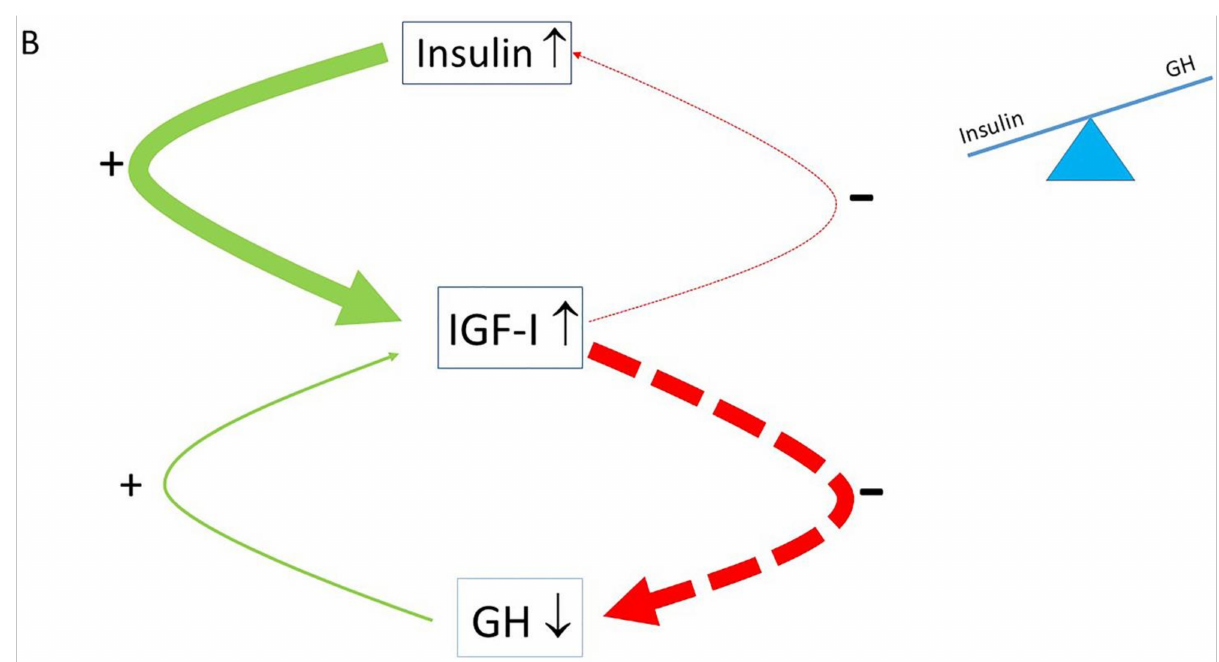
Figure 1. The insulin–growth hormone–IGF-I (insulin–GH–IGF-I) axis plays a central role in metabolism. ( A ) In healthy subjects, the insulin–GH–IGF-I axis is in balance: insulin and GH both stimulate IGF-I production in the liver, while after secretion IGF-I feeds back to suppress both insulin and GH. ( B ) The continuous food intake and energy surplus (Western diet) in modern societies has disturbed the normal balance of the insulin–GH–IGF-I axis. As a consequence, a shift of the insulin : GH ratio towards insulin (and IGF-I) and away from GH has occurred. The higher insulin : GH ratio lowers energy expenditure and induces fat accumulation. This insulin–GH shift promotes energy storage and lipid synthesis and hinders lipid breakdown, resulting in obesity due to higher fat accumulation and lower energy expenditure (see text for more details on how continuous foods intake and Western diet may influence the balance of the insulin–GH